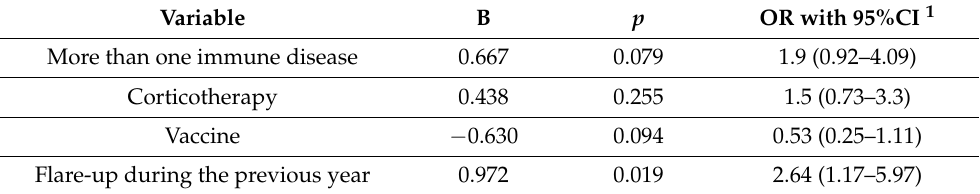
Figure 2. The Kaplan–Meier curves for the flare-ups in the vaccinated and non-vaccinated groups. In bivariate analysis, the flare-ups were associated with having more than one immune disease, taking corticosteroids, and with a previous flare-up during the past year (Table 1). In the Cox model, only having a flare-up during the previous year was associated with a flare-up (Table 3). Table 3. Determinants of the flare-ups (Cox model) .